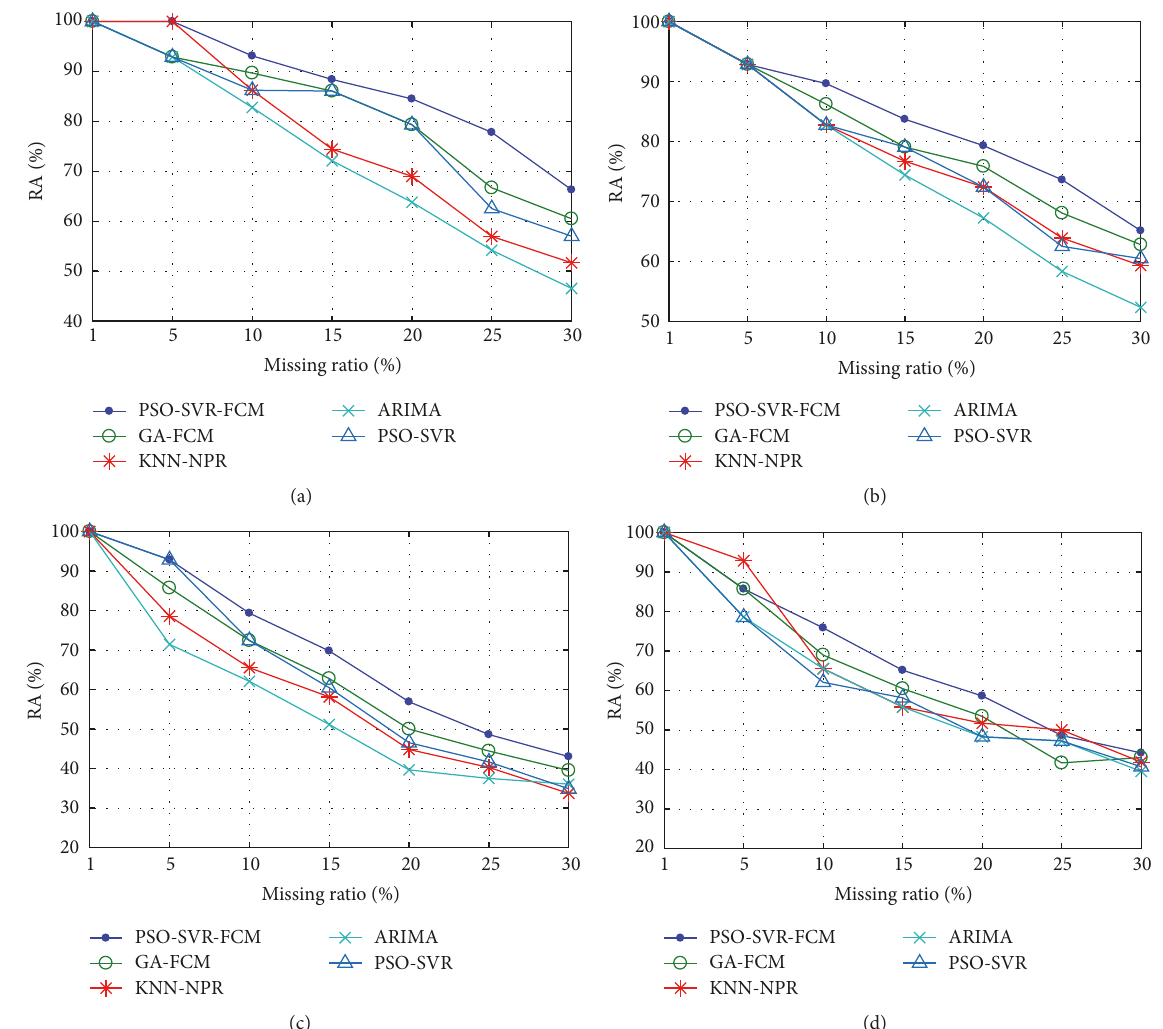
Figure 13: The RA curve of each method for comparison in MCR pattern, using the traffic data collected from the detectors (a) NBXX13 (2) , (b) NBXX11 (4) , (c) DC00004964(E2), and (d)